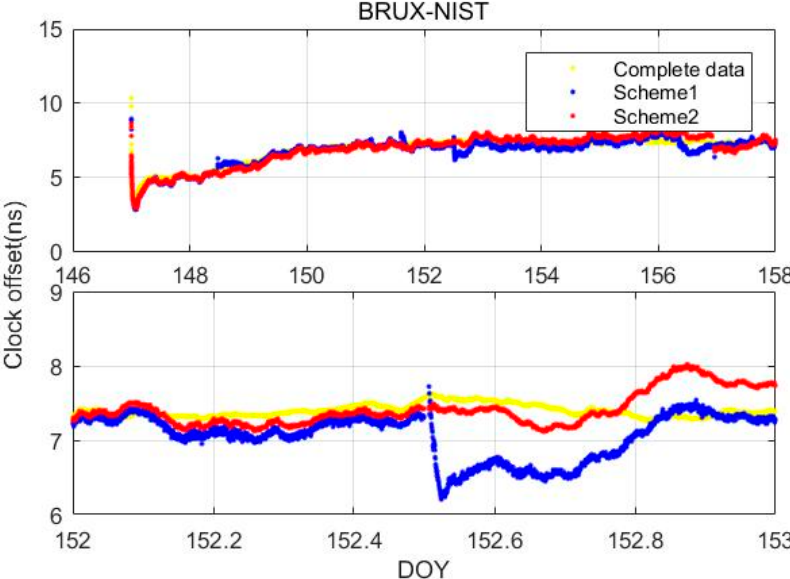
Figure 10. Clock offset time series of scheme 1 ( blue ) and scheme 2 ( red ); the yellow colour represents